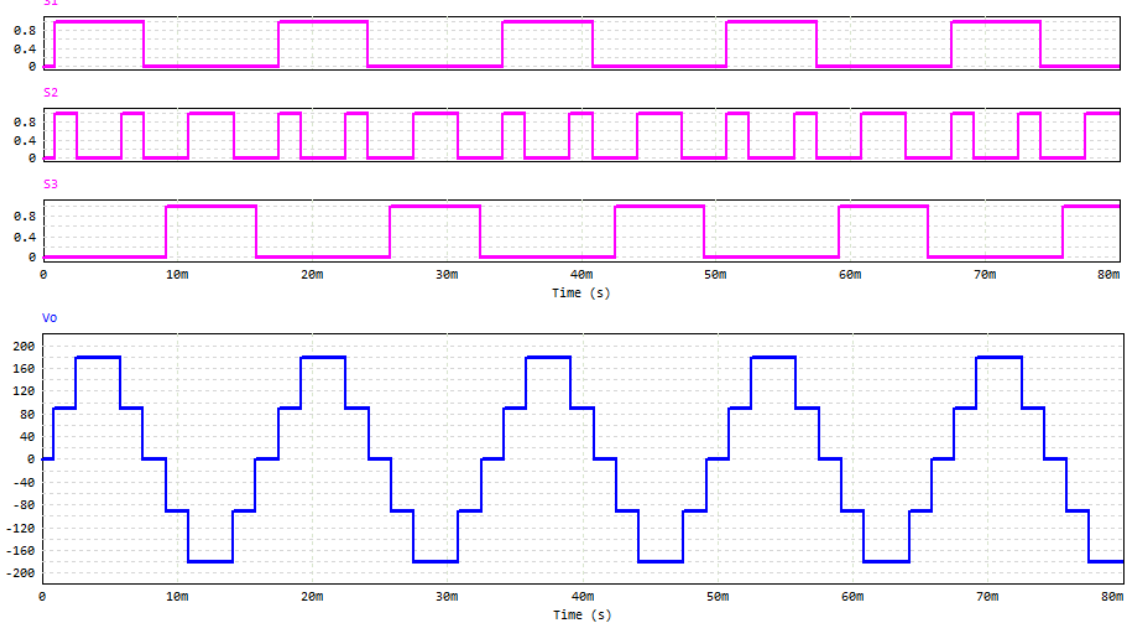
Figure 23. Switching signals and the output voltage.